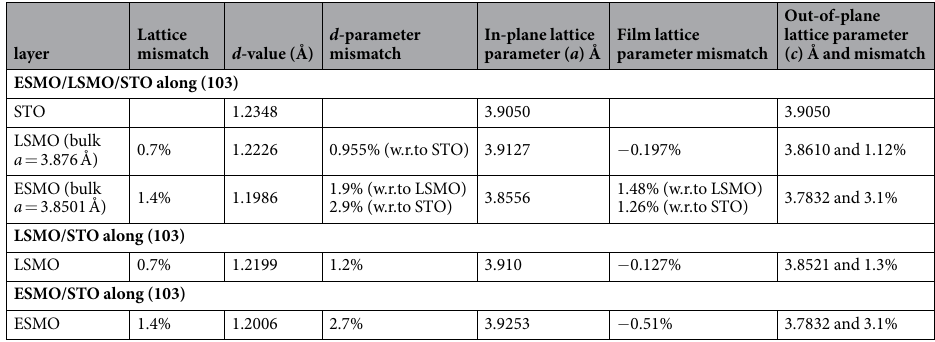
Table 1. List of in-plane ( a ), out-of-plane ( c ) lattice parameters and inter-plane spacing ( d ) and lattice mismatch of ESMO/LSMO bilayers and single LSMO and ESMO references layers on STO obtained from the asymmetric RSM data along (103) reflection.